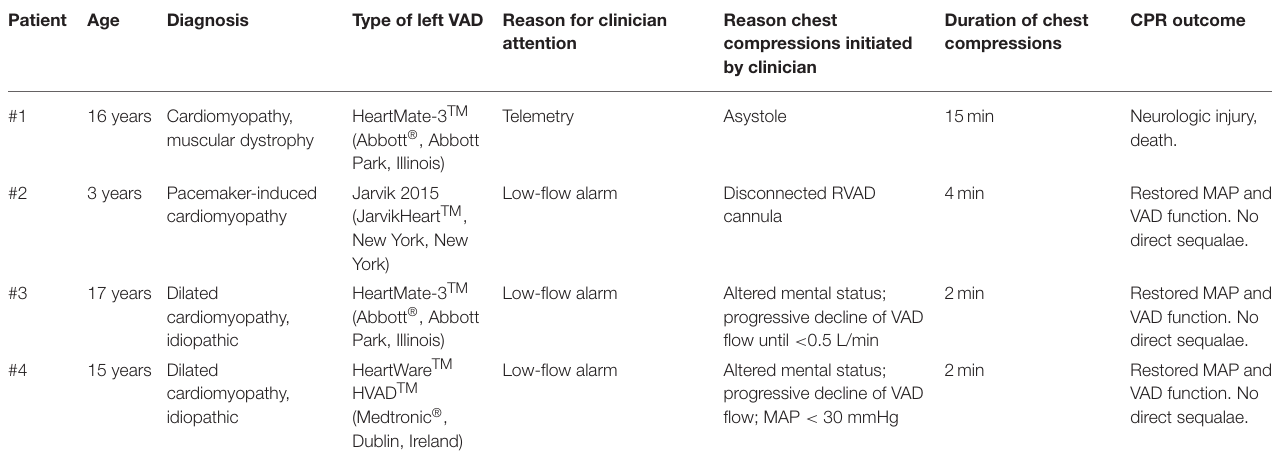
TABLE 1 | Summary of patient